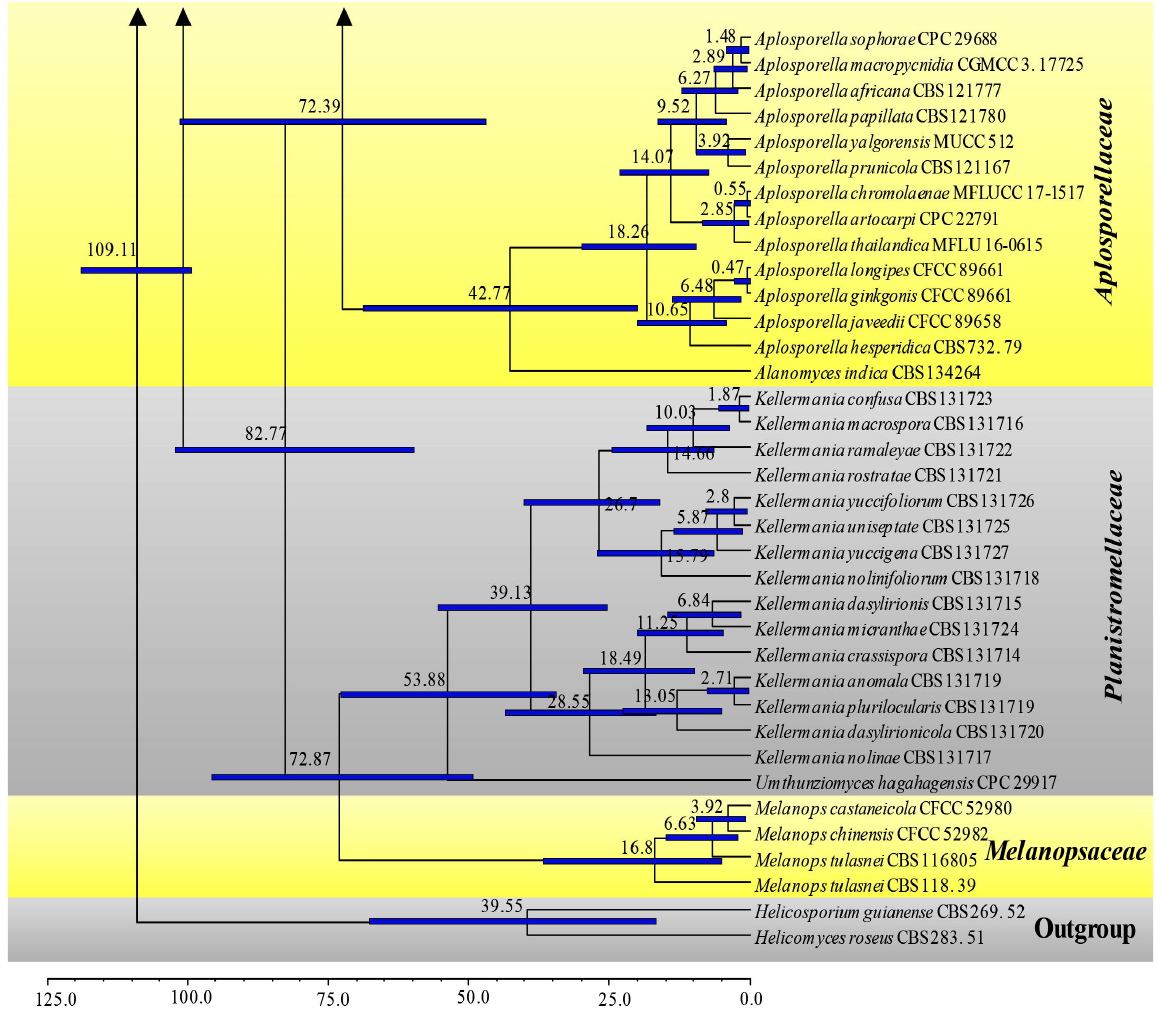
Figure 4. Maximum clade credibility (MCC) tree for LSU and ITS sequence data using a GTR+G+I nucleotide substitution model. The tree was calibrated by setting the crown age of Botryosphaeriales at 110 Mya. Values at the nodes are given in millions of years and the blue bars indicate standard deviations.